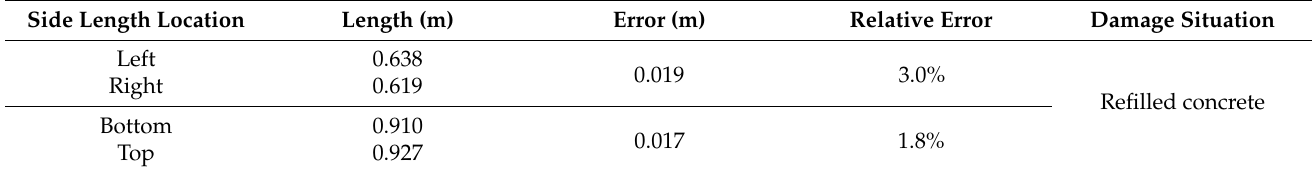
Table 8. Accuracy analysis for side length measurement at a photo-shooting distance of approximately 2.9